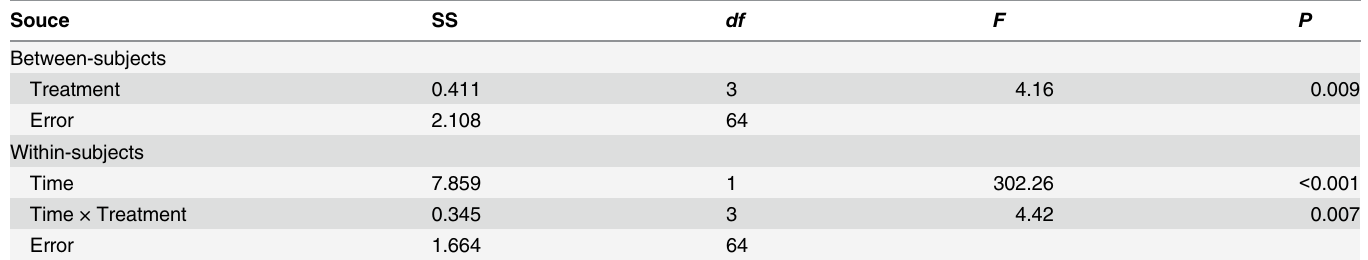
Table 6. Repeated measures ANOVA of the number of eggs laid by virgin females following injections with no, a high, medium, or low molecular- weight fraction of male accessory gland extracts (treatment) (N = 16 – 19 females per treatment group). Souce